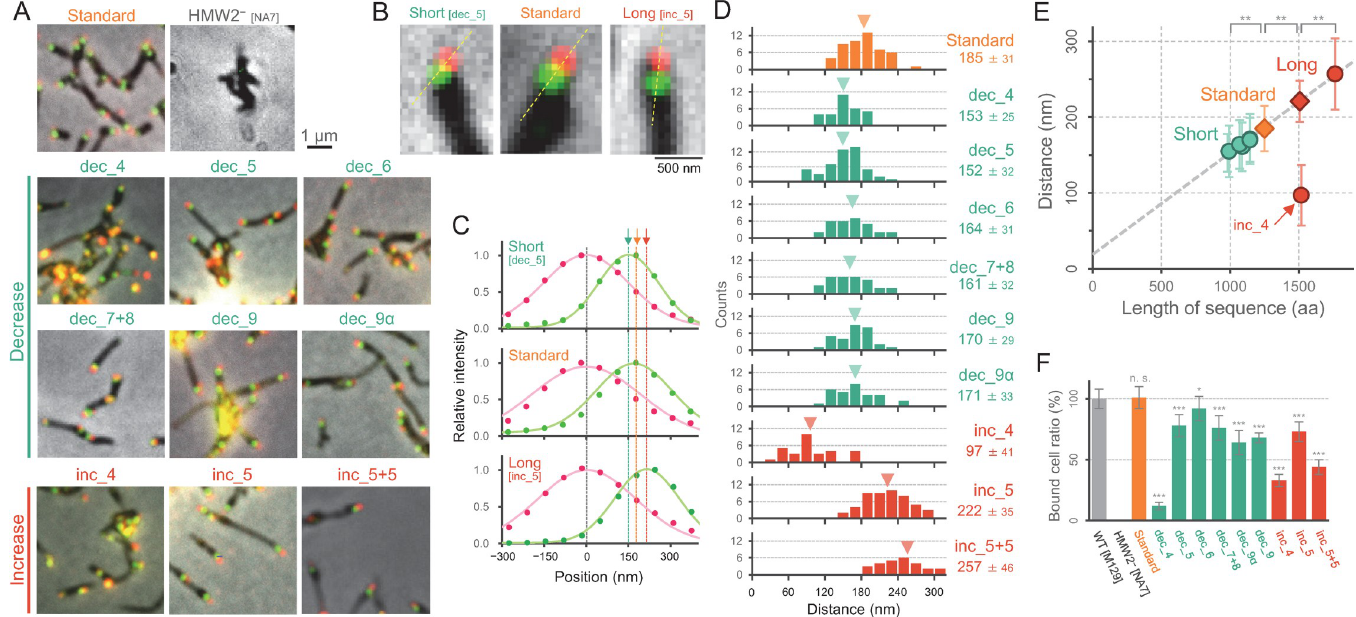
Fig 3. Localization of the size-modified HMW2 derivatives in the attachment organelle. (A) Cell images. Fluorescence and phase-contrast images were merged. (B) Magnified images of the attachment organelle in dec_5, standard, and inc_5. (C) Measurement of peak positions between mCherry and EYFP signals. Fluorescent intensities along the dashed line in B were plotted with Gaussian distribution. (D) Distribution of the distance between two signals. The average and SD of 30 cells were presented, and the averrage was marked by a triangle in each panel. (E) Relationship of the distance between mCherry and EYFP signals, and the total amino acid numbers of coiled-coil domains in HMW2. The average and SD in panel D were plotted. Except for the data from inc_4 strain, the linear fitting was shown as a dashed line (see in S3 Fig for more detail). (F) The ratio of cells bound to glass. The number of cells in 62 × 35 μ m 2 area was counted after washing unbound cells at RT. The average and SD of 12 independent experiments were presented. Statistical analysis followed by t -test are shown; �� p 0.01, n. s. no significance.